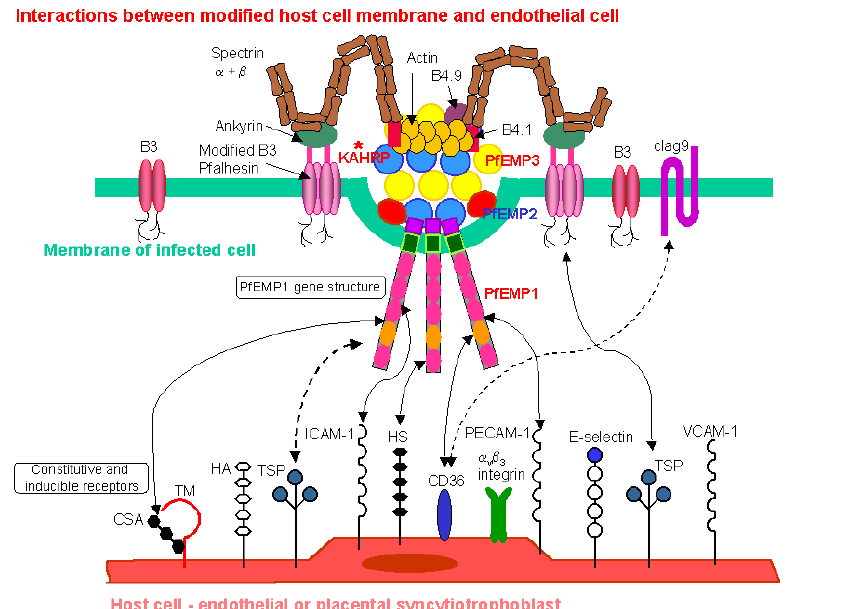
Schematic representation of the wide array of molecules involved in the adhesive molecular interaction between P. falciparum infected red blood cells and the vascular endothelial